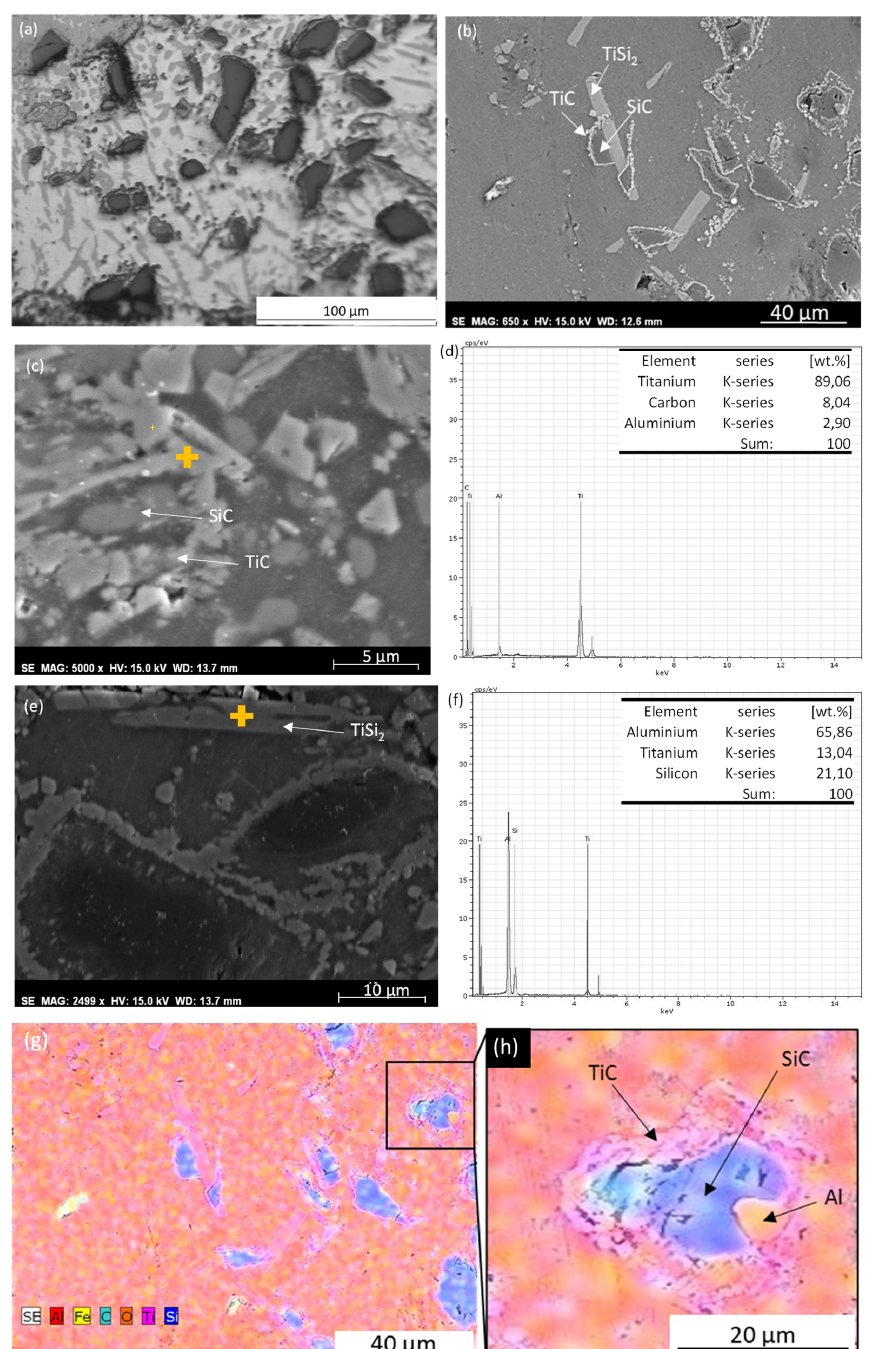
Figure 5. Al-Ti / SiCp ( a ) OM image, microstructure general view; ( b ) SE image; ( c ) detail of TiC particles; ( d ) EDS analysis made on the surface shown in ( c ); ( e ) Detail of TiSi 2 particles; ( f ) EDS analysis made on the surface shown in ( e ); ( g ) EDS elements map; color code: aluminum in red, silicon in blue, carbon in cyan, oxygen in orange, titanium in purple, and iron in yellow; ( h ) detail of SiC particle.